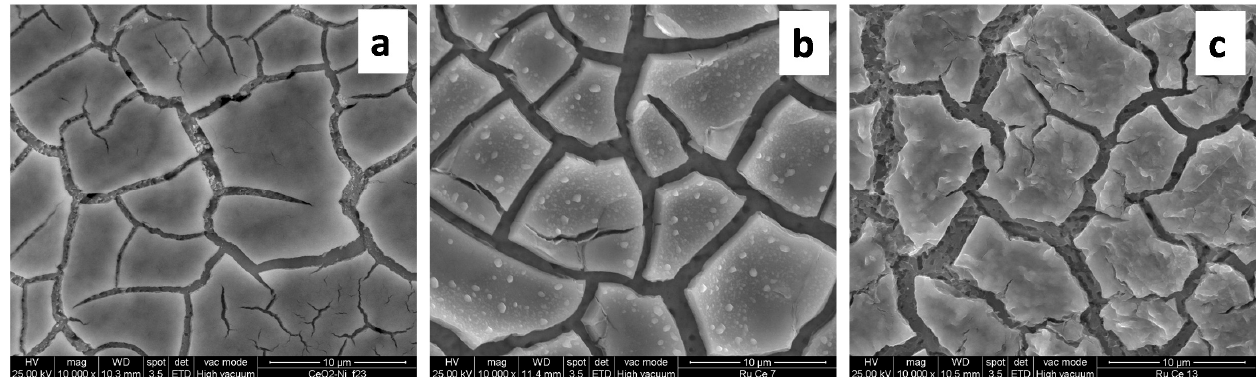
Figure 7. SEM images of Ce 12 /Ni ( a ), Ru/Ce 12 /Ni ( b ), and Ru/Ce 36 /Ni ( c ) recorded after methanation tests.